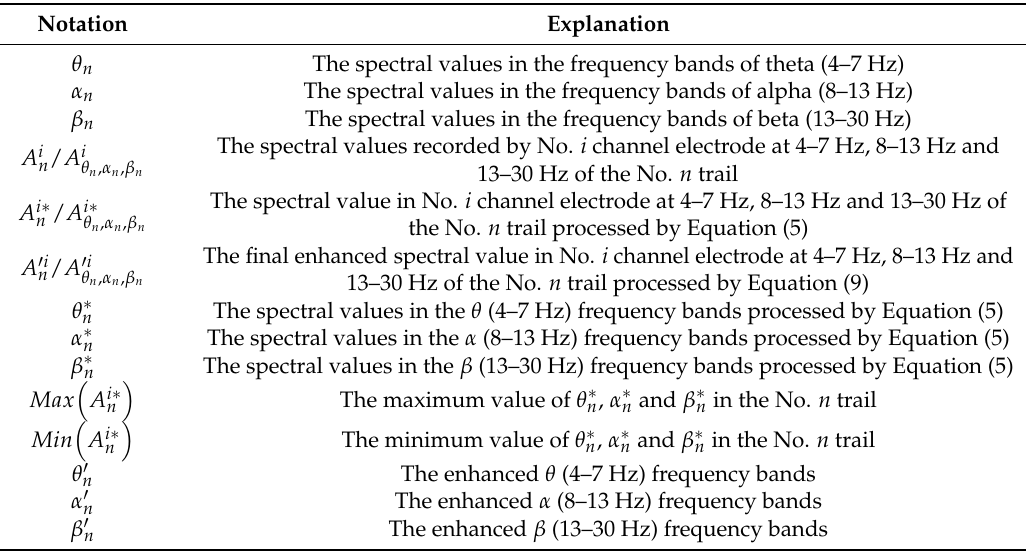
Figure 4. ( a ) 3D image of the θ channel; ( b ) 3D image of the feature-enhanced θ ’ channel; ( c ) 3D image of the α channel; ( d ) 3D image of the feature-enhanced α ’ channel; ( e ) 3D image of the β channel; ( f ) 3D image of the feature-enhanced β ’ channel. Table 1. The explanation of variables.